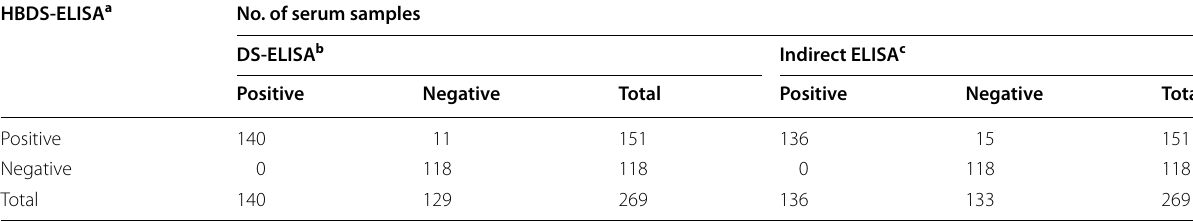
0.20; negative <0.20 ≥